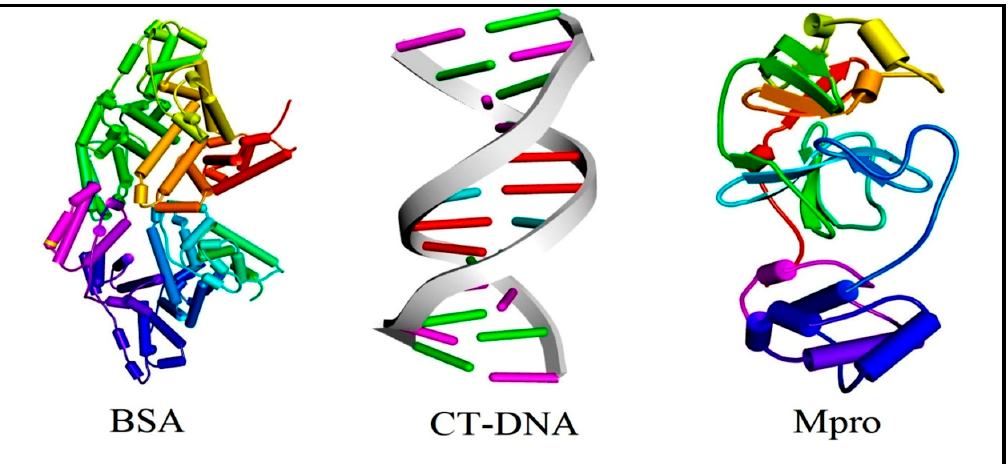
Figure 10. The schematic structures of the three biomacromolecules considered for docking studies of ligand ( HL ) and complexes ( 1b – 2b ). Only one protomer of the dimeric Mpro enzyme is provided.